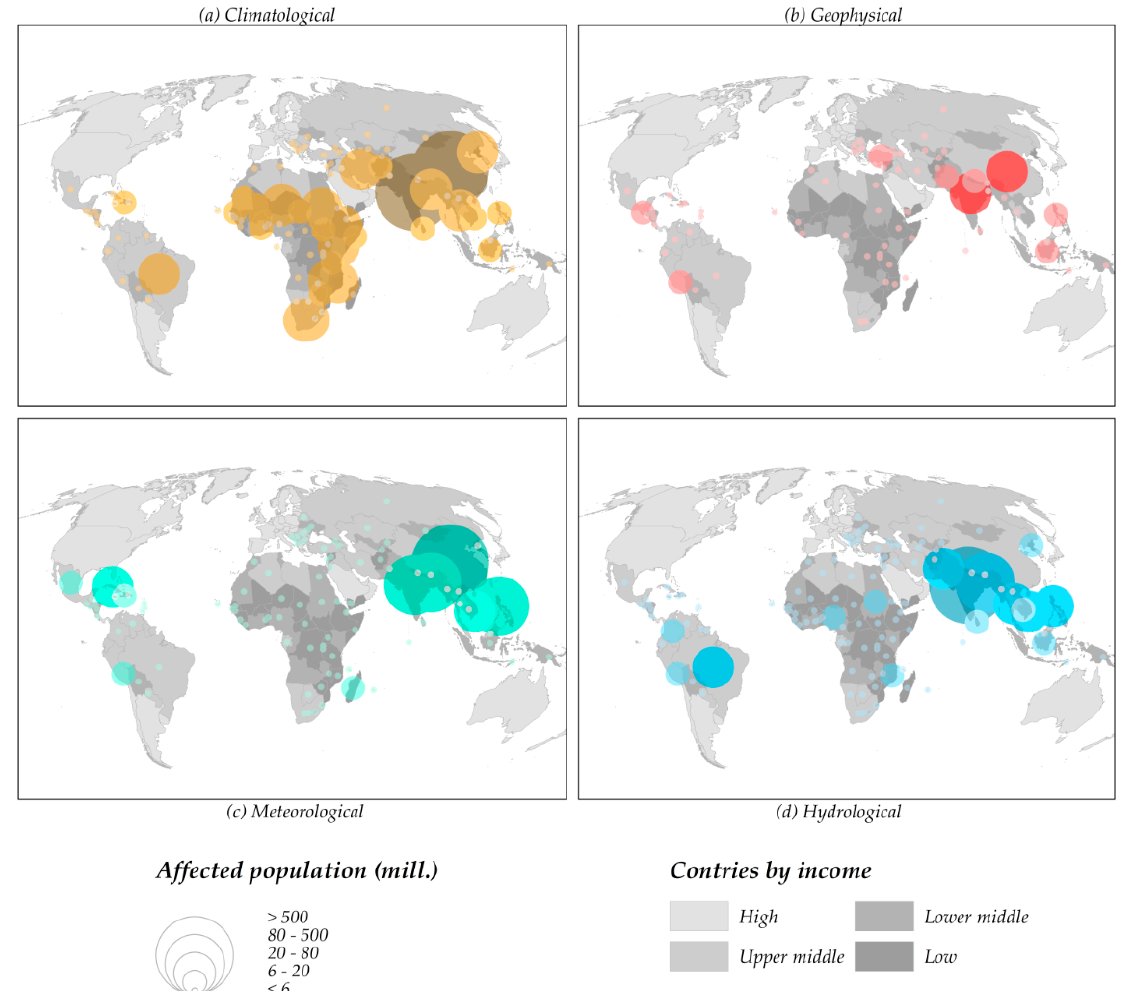
Figure 1. Proportional symbols represent the total amount of population (in millions of people) affected from 1900 to the present by different types of natural disasters, excluding the high income countries. The groups are based on D. Guha-Sapir, R. Below, Ph. Hoyois—EM-DAT: The CRED/OFDA International Disaster Database—https://www.emdat.be/—Universit é Catholique de Louvain—Brussels—Belgium classification. ( a ) Climatological disasters, including droughts, glacial lake outbursts, and wildfire; ( b ) geophysical disasters, including earthquakes, mass movement (dry), and volcanic activity; ( c ) meteorological disasters, including storms, extreme temperature, and fogs; and ( d ) hydrological disasters, including floods, landslides, and wave action. The world map representing the country classification by incomes is based on https://datahelpdesk.worldbank.org/knowledgebase/articles/906519-world-bank-country-and-lending-groups. The grey scale ranges from high income (light grey) to low income countries (dark grey). (Coordinate system: Sphere Mollweide; map scale